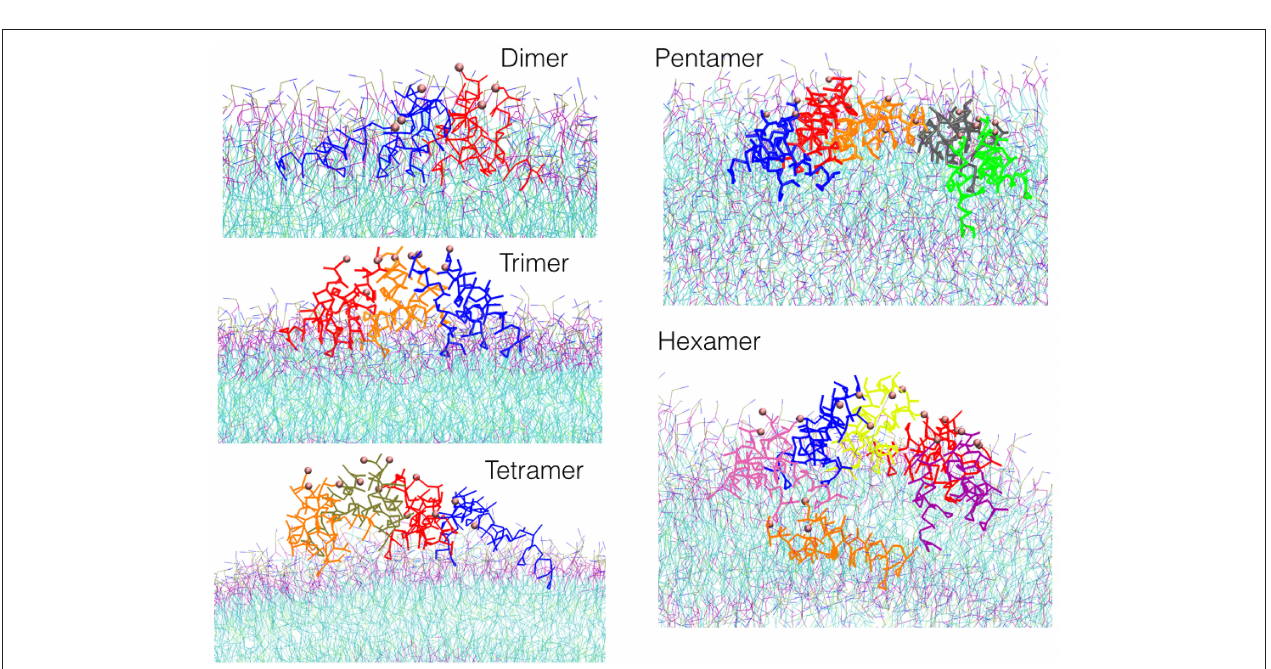
FIGURE 3 | Evolution of the oligomer formation as a function of time. Oligomerization was measured every microsecond. The data shown here is from one replica but is representative of the behavior observed in the other replicas. The monomers are represented in pink, the dimers in cyan, the trimers in orange, the tetramer in blue, the pentamer in violet and the hexamer in green.